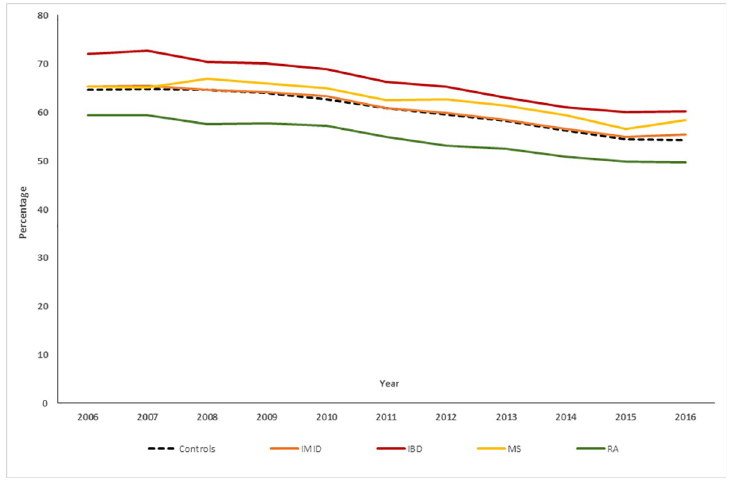
Fig 2. Pap testing frequencies for 2006–2016 age-standardized to 2010